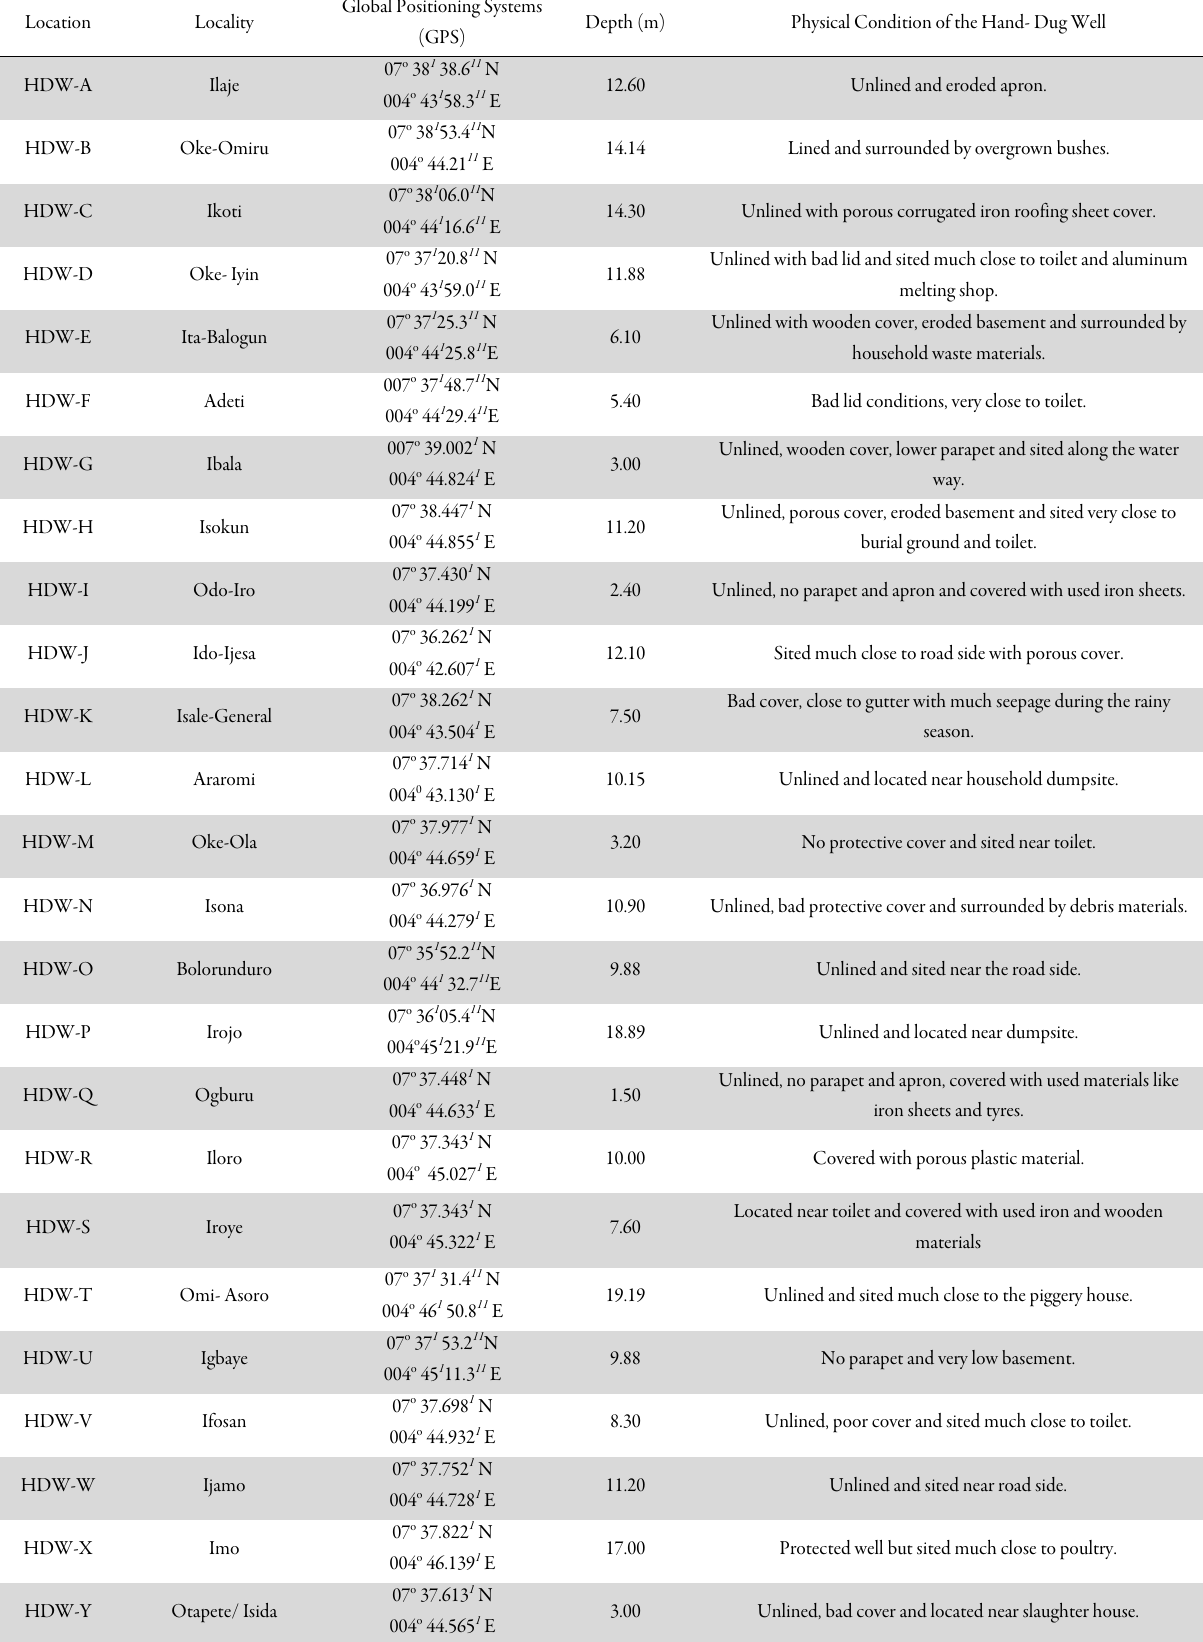
Table 1. Description of physical features and geographical location of the wells